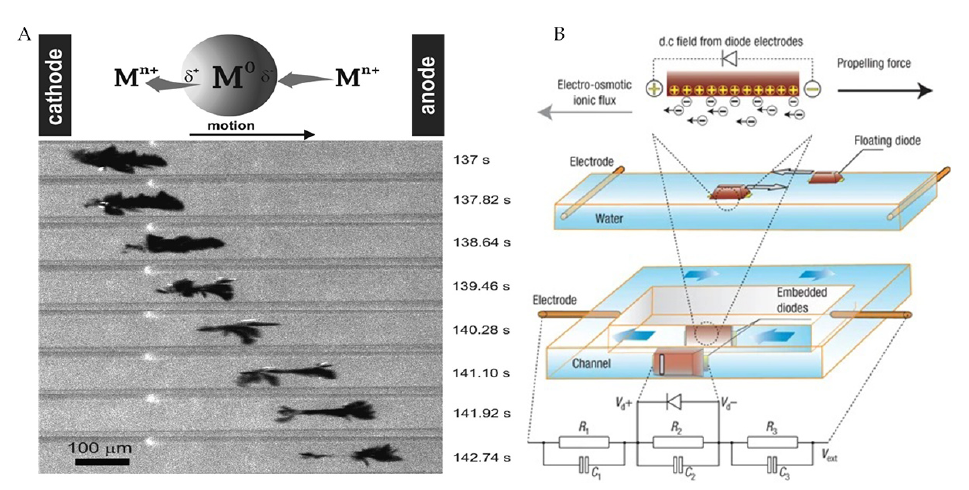
Figure 5. ( A ) Dynamic bipolar self-regeneration actuated swimmer. Adapted with permission from ref [50]. Copyright 2010 American Chemical Society. ( B ) Electroosmotic flow propulsion caused by local rectification. Reprinted with permission from [49]. Copyright 2007 Springer